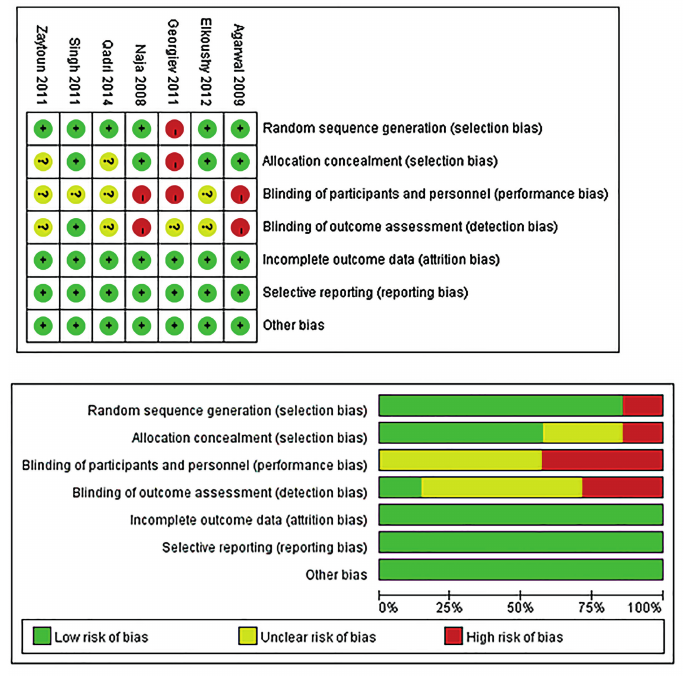
Supplementary Figure 2 - Risk-of-bias analysis: (A) Risk of bias summary: Review authors’ judgments about each risk of bias item for each included study. (B) Risk of bias graph: Review authors’ judgments about each risk of bias item presented as percentages across all included studies.